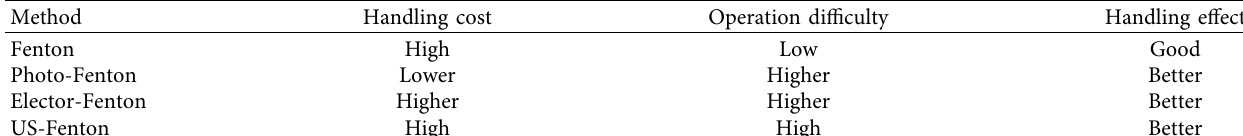
Table 1: Comparison of the Fenton method and Fenton-like method.